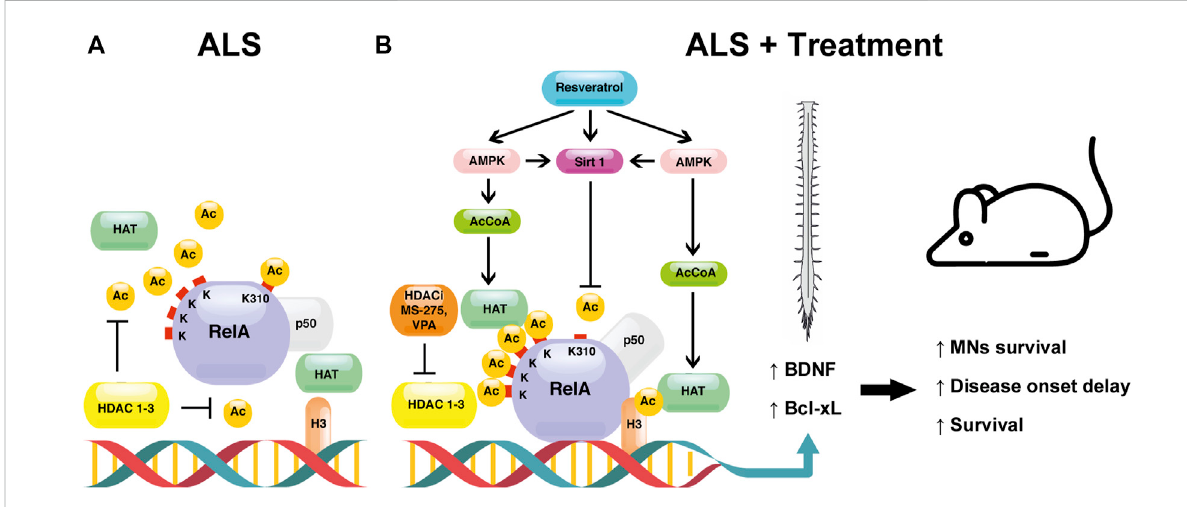
FIGURE 1 The proposed mechanism underlying the effect of the combination between resveratrol and HDAC inhibitors (HDACi) [MS-275 or valproate (VPA)] in ALS. (A) In the spinal cord of the SOD1(G93A) ALS mouse model, NF- κ B/RelA is present in its aberrantly acetylated form, consisting of a hypoacetylated state with the exception of the residue K310 (ALS). In this pathological condition, the acetylation of histone H3 is decreased. (B) The treatment of SOD1(G93A) mice with the combination resveratrol/HDAC inhibitors reverts the aberrant RelA acetylation (ALS + treatment). HDAC inhibitors, by blocking HDAC activity, induce HAT-mediated acetylation of both RelA and H3 histone. Resveratrol activates the class III NAD+ -dependent HDAC SIRT1, promoting the deacetylation of RelA at residue K310. Moreover, resveratrol stimulates AMPK pathway, leading to an increase of NAD+ and AcCoA levels, enhancing the activation of SIRT1 and HATs, respectively. The modulation of RelA and H3 acetylation in the nucleus promotes the transcription of the anti-apoptotic Bcl-xL and the neurotrophic BDNF factors. Altogether, the treatment leads to a protection of MNs, a delay of symptoms ’ onset, and longer